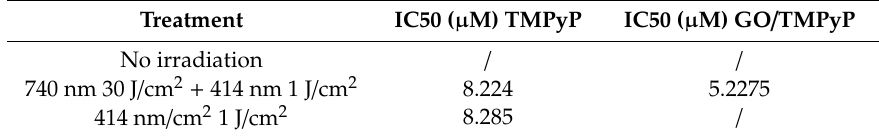
Table 1. IC50 of TMPyP and GO / TMPyP nanocarrier. Notes: IC50 marked; / , could not be determined due to higher cell viability than 50% at concentrations 0–25 µ